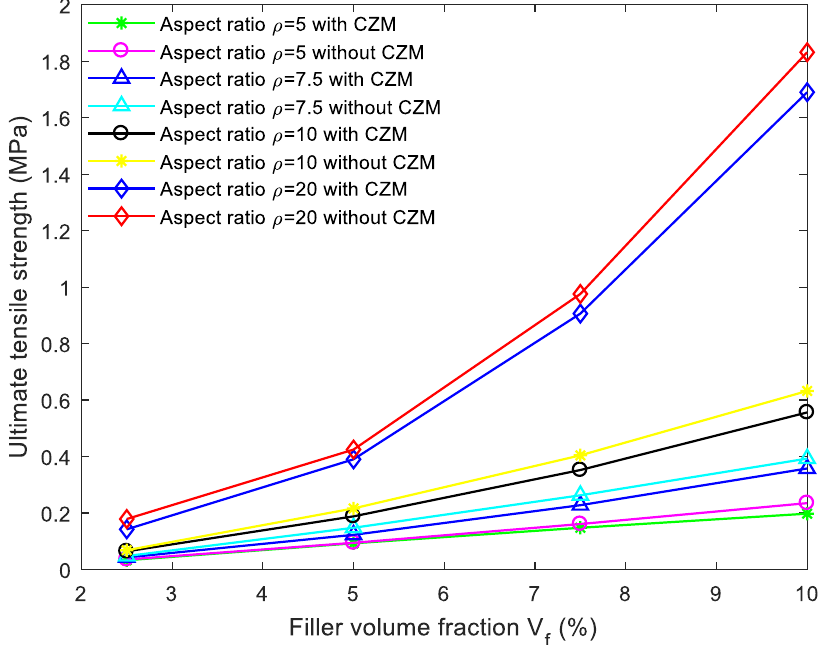
Figure 8. Variations of the effective ultimate tensile strength σ ult with the clay nanoparticle volume fraction V f at the aspect ratio of ρ = 5, 7.5, 10, and 20, respectively.